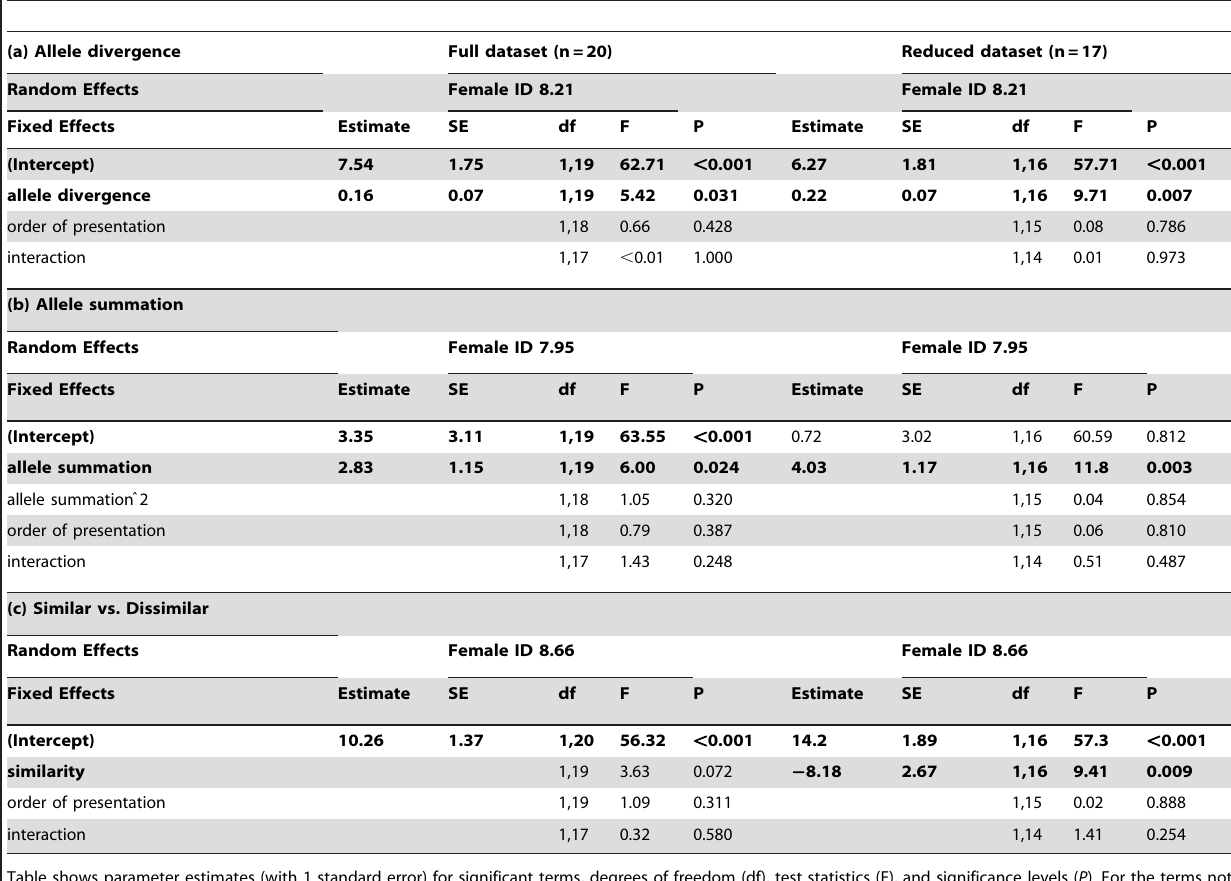
Table 2. General Linear Mixed Models explaining female mate choice decision based on three measures of mate dissimilarity.